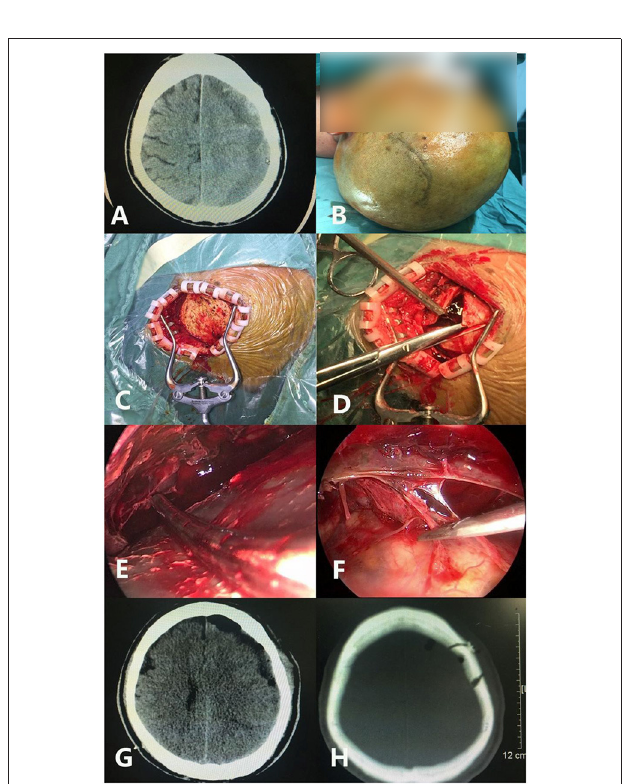
FIGURE 6 | A case of septated chronic subdural hematoma under endoscopic evacuation. (A) Preoperative CT shows the subdural hematoma separation. (B) The skin incision is located at the coronal suture, with a backward ‘C’ shape. (C) The skin is open after incision. (D) After the valve is formed, the dura mater is cut in a cross shape. (E) The S shape of the suction device is used to push the brain tissue during the operation to expose the hematoma distant from the bone window. (F) The separation is cut. (G) Postoperative CT examination shows that the hematoma was removed satisfactorily. (H) The position, size (about 2–3 cm), and shape of the actual bone window is shown.